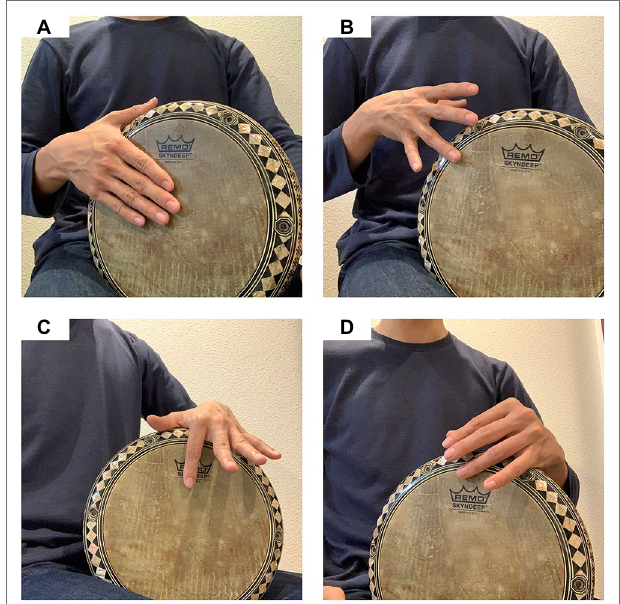
FIGURE 1 | An example of playing a percussion “darbuka” by a right- handed musician. To play the darbuka, the players mainly make three sounds named “Doum” (a low-pitch sound), “Pa” (a slapping sound), and “Tek” (a high-pitch sound). The Doum and Pa sounds are made by striking the center of a drum head by a preferred hand (A) . The Tek sound is made by striking the edge of a drum head with a ring finger of a preferred hand (B) , or an index or a ring finger of a non-preferred hand (C,D)